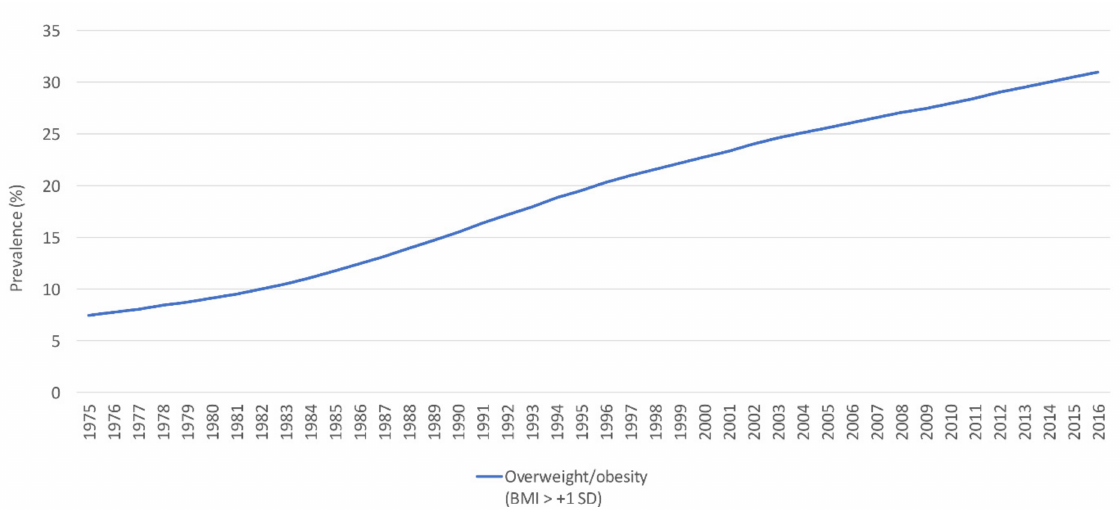
Figure 5. The trend in the prevalence (%) of overweight/obesity (BMI > + 1 SD) among school-aged children and adolescents (5–19 years old), modeled data (1975–2016). Abbreviations: BMI: body mass index; SD: standard deviation. Source: WHO, 2021 [60].